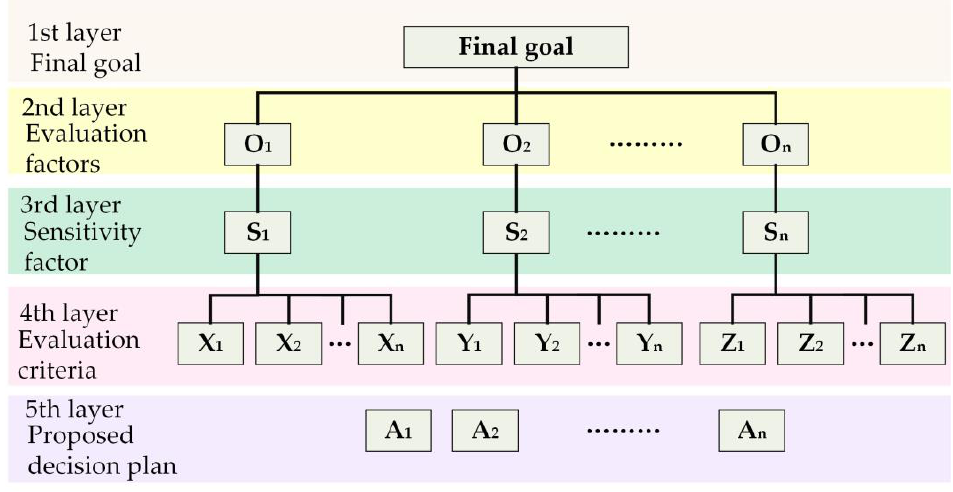
Figure 5. Structural diagram of the proposed CSAHP.